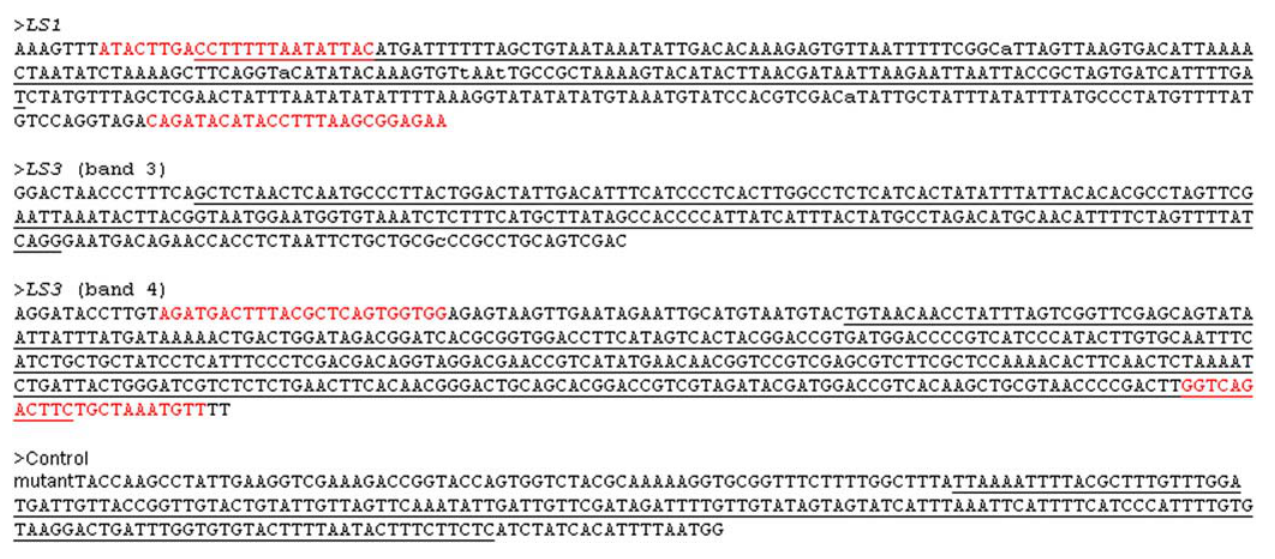
(Figure 3 and Table 1). The number of sequence similarity hits along the 12 chromosomes is presented in Table 1. Bands 2, 3 and 4 sequences identified most hits in chromosomes 4, and 8,